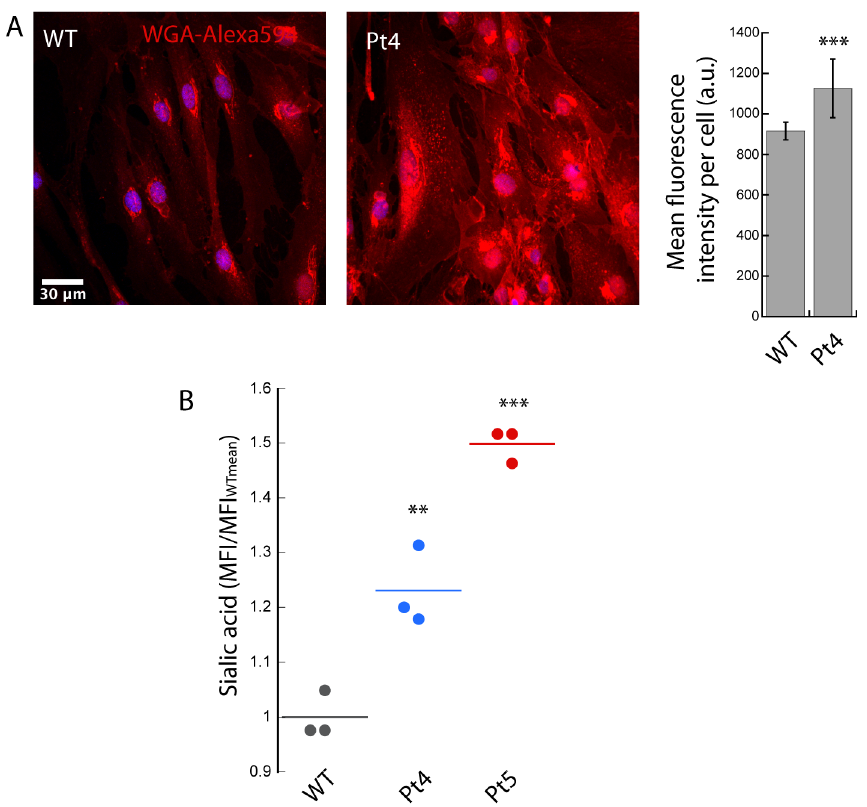
Figure 2. Sialidosis. Thawed primary cultures of fibroblasts isolated from control and Sialidosis patients (Pt4 and Pt5) were cultured, fixed, permeabilized, labeled with WGA-594, and imaged with CLSM ( A ) or analyzed with flow cytometry ( B ). ( A ) The Pt4 patient shows higher values of WGA-594 fluorescence intensity compared to WT control, indicating a rise in content of molecules containing sialic acid groups. Scale bar 30 µ m. >20 cells were analyzed for each condition. Error bar S.D. ( B ) MFI/MFI WTmean values increased in the fibroblast populations of both patients (Pt4 and Pt5) analyzed with respect to control. >5000 cells were analyzed for each MFI. Student’s t -test ** p ≤ 0.01, *** p ≤ 0.001.